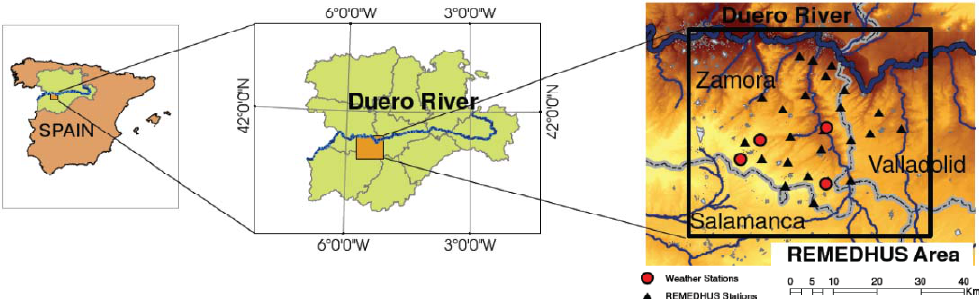
Figure 11. Location of the REMEDHUS calibration and validation site in the central part of the Duero basin, Spain Layout of the 23 permanent soil moisture stations within REMEDHUS soil moisture measurement